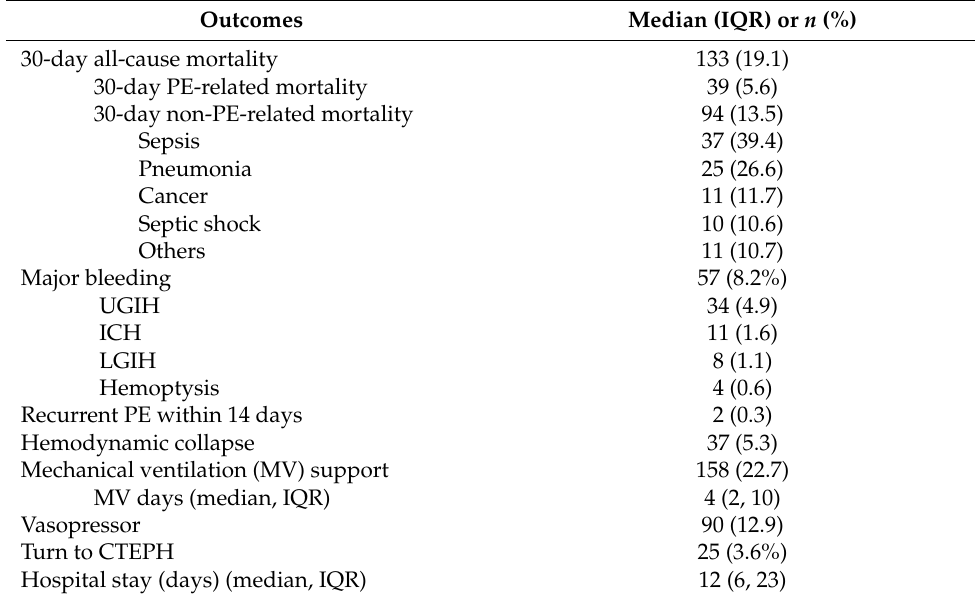
Table 4. Outcomes of Patients with Acute Pulmonary Embolism ( n = 696).